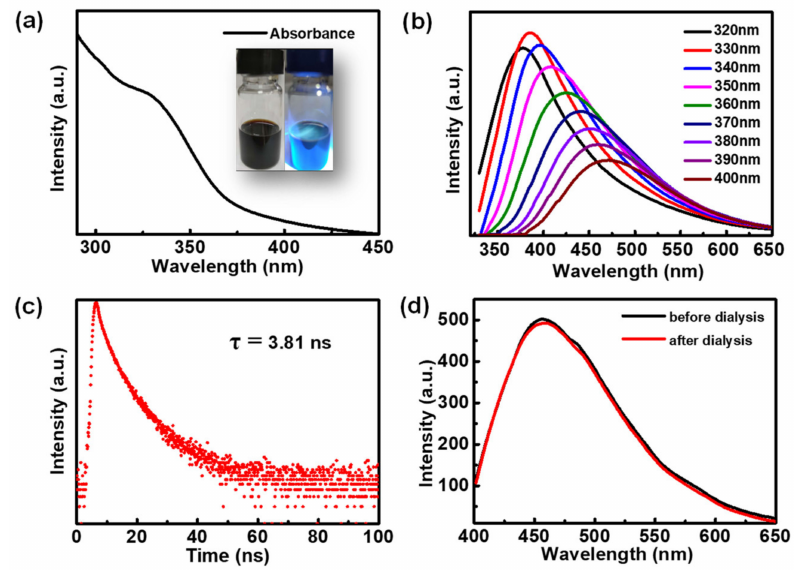
Figure 4. ( a ) UV–vis absorption spectrum of an aqueous solution of F-CDs. The inset shows digital pictures of an aqueous solution of F-CDs taken under daylight and an ultraviolet light, respectively. ( b ) PL emission spectra of F-CDs measured under different excitation wavelengths starting from 320 to 400 nm. ( c ) PL decay curve of F-CDs obtained at emission wavelength of 385 nm. ( d ) PL emission spectra of F-CDs during the pre- and post-dialysis